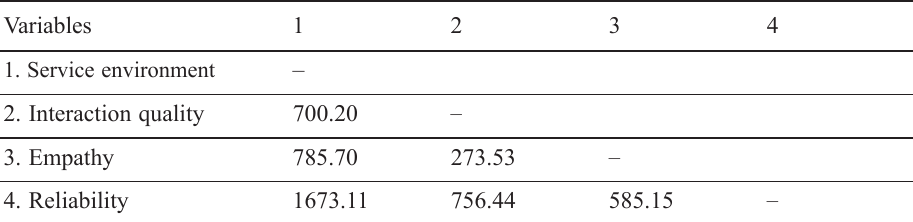
Table 2. Discriminant validity: chi-square difference